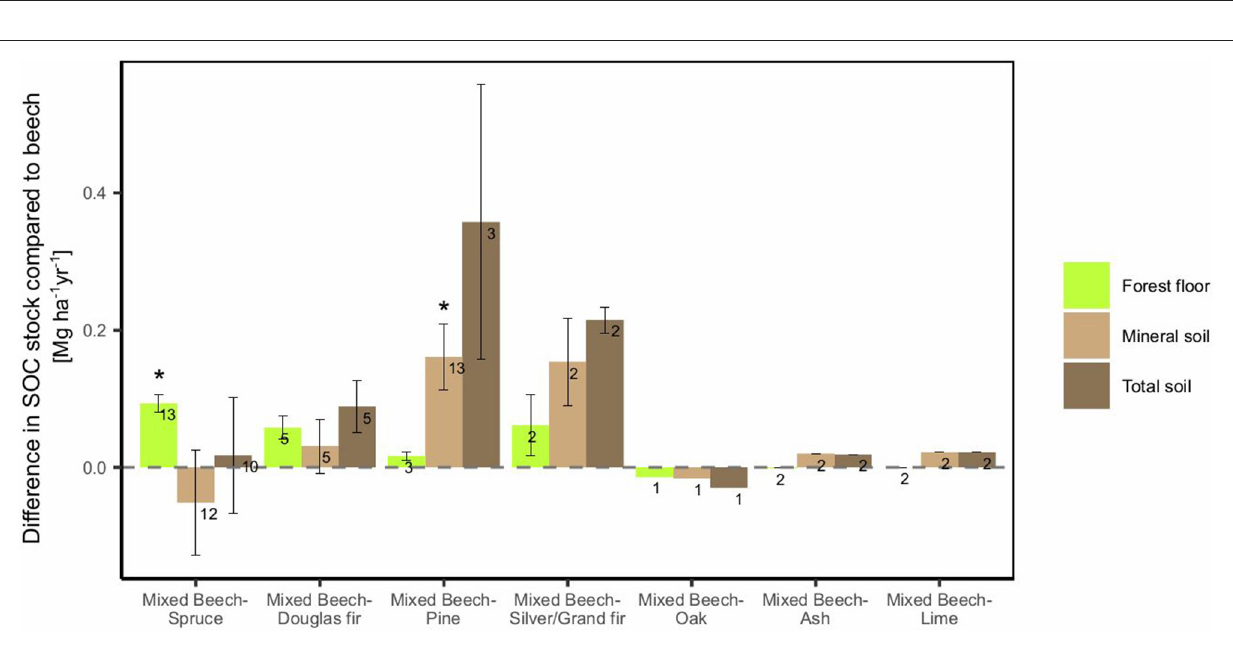
monoculture. Up to doubled organic C stocks were found in fir stands compared to beech monocultures ( Supplement 5B